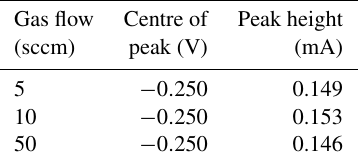
Table 1. Peak data of the H 2 oxidation peaks from Fig. 11.